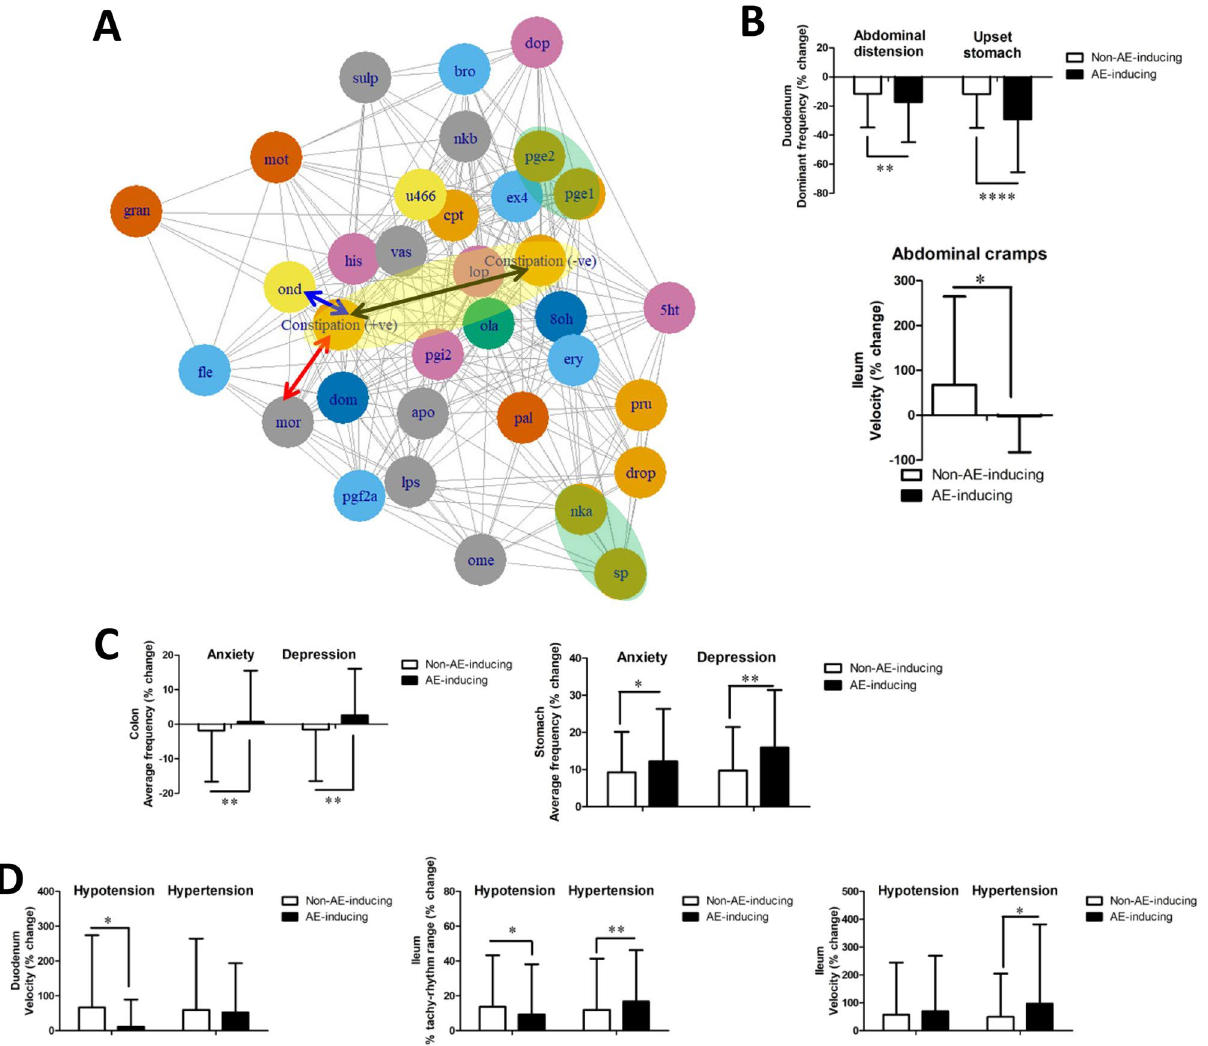
Figure 4. Selected GI pacemaker features correlated with AEs. (A) Network graph clustering selected drugs by refined EFs to an example AE: constipation. The length of black arrow represents how good the model may distinguish between positive-correlated features and negative-correlated features in constipation (shaded in yellow). Blue arrow and red arrow has a short distance to positive-correlated features of constipation, where these two drugs ondansetron (“ond”) and morphine (“mor”) are known in market to induce constipation. Drugs acting on similar receptors, such as prostaglandin E1 (“pge1”) and prostaglandin E2 (“pge2”) or substance P (“sp”) and neurokinin A (“nka”) are clustered close to each other based on EF drug profile (shaded in yellow) (B–D) The percentage change of selected features compared between AE-inducing drugs and non-AE-inducing drugs in (B) GI-related AEs, (C) psychology-related AEs and (D) hypotension vs. hypertension. Data represents the mean ± S.D. Significant differences are indicated as *p < 0.05, **p < 0.01, ***p < 0.001 using unpaired t-tests (n = 228–1300). NKA neurokinin A, LPS